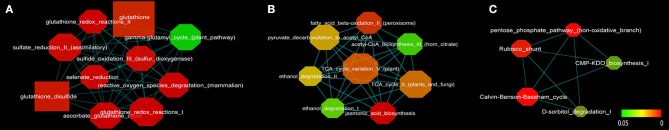
Sub-network association of pathways at selected time points. (A) Sub-network of redox metabolism at 3 h cold acclimation. (B) Sub-network of energy metabolism at 3 h cold acclimation. (C) Sub-network of carbon metabolism at 12 h cold acclimation. Red color range shows most significant genes, metabolites, and pathways.